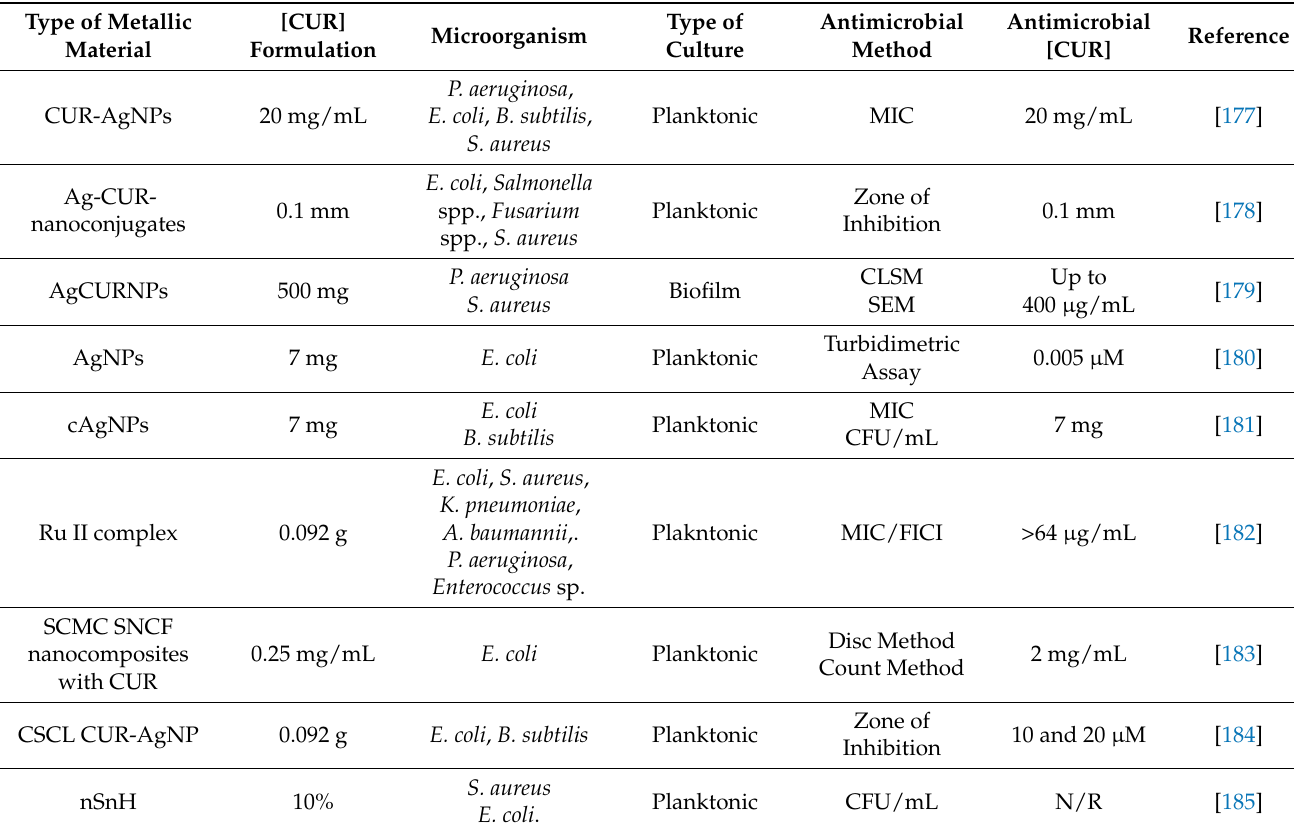
Figure 6. Schematic representation of CUR in silver nanoparticles. Table 8. Antimicrobial studies performed with CUR complexes with metallic